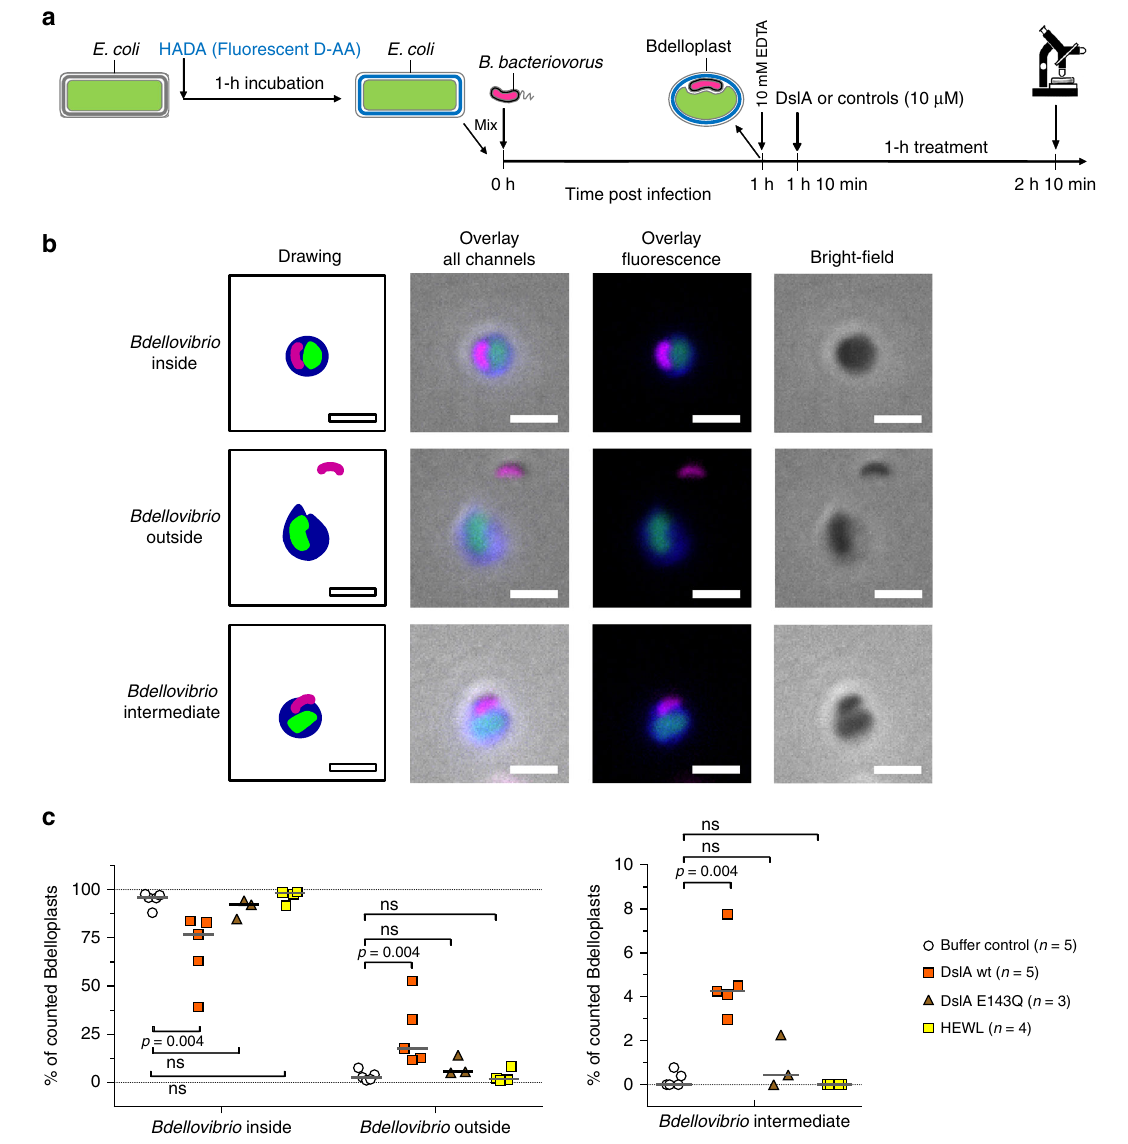
Fig. 5 Exogenously added lysozyme DslA releases B. bacteriovorus from 1 h bdelloplast. a Experimental scheme including different stains/ fl uorescent proteins to enhance visualization of different compartments. The experimental outline is described in the legend of Supplementary Fig. 8. b Example images of different outcomes after treatment copied from Supplementary Fig. 8. B. bacteriovorus bd0064:mcherry is shown in magenta, prey peptidoglycan in blue. Scale bar is 2 μ m. c Percentage of bdelloplasts categorized according to the position of the Bdellovibrio in respect to the bdelloplast after treatment as described above (Supplementary Fig. 8). Individual symbols represent % of all categorized bdelloplasts per experiment. A minimum of 71 bdelloplasts per treatment condition and biological repeat were evaluated (for details please refer to Source Data fi le). The number of biological repeats is indicated in the legend as n for the respective treatment. Horizontal lines represent median, statistical test was Mann – Whitney, ns non-signi fi cant, p -values = 0.004 (all p -values are one-tailed). HEWL hen egg-white